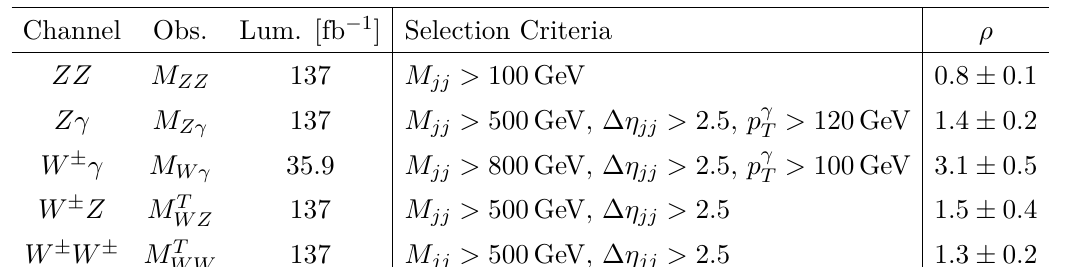
Table 3 . Summary of the CMS VBS analyses: the diboson mass observable, the integrated luminosity, the most important selection criteria and the normalization scale factor ρ .